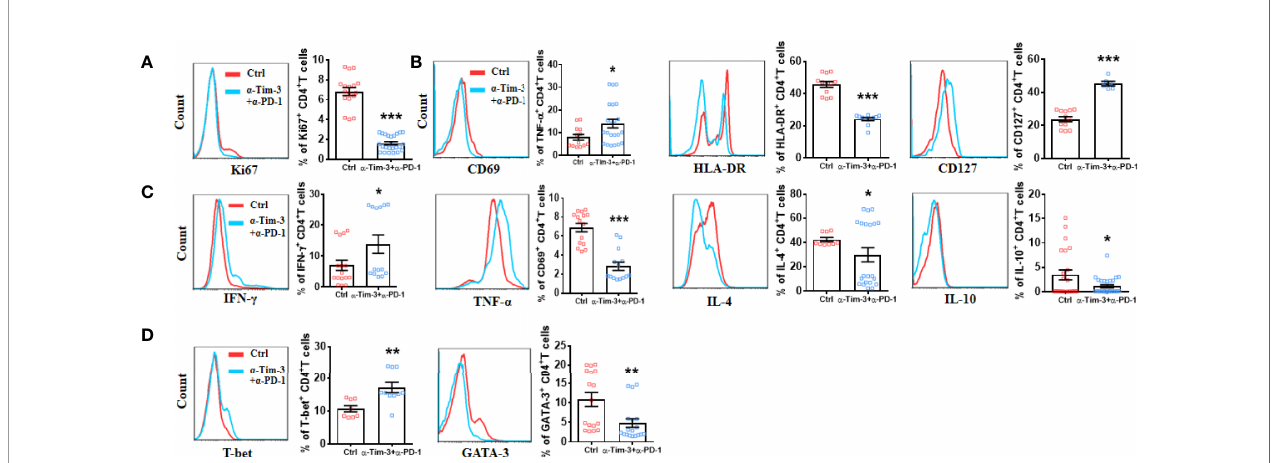
FIGURE 4 | Effect of in vitro targeting Tim-3 and PD-1 signaling pathways on CD4 + T cell function from LEASO patients. Quanti fi cation of fl ow cytometric analysis of Ki67 expression (A) , activation markers (B) , cytokine production (C) , and Th1-type and Th2-type transcription factors (D) by CD4 + T cells from LEASO cultured for 48 h in the presence or absence anti-Tim-3 and anti-PD-1 antibodies. Data represent mean ± SEM (n = 16). *P < 0.05, **P < 0.01, ***P < 0.001, compared with the control